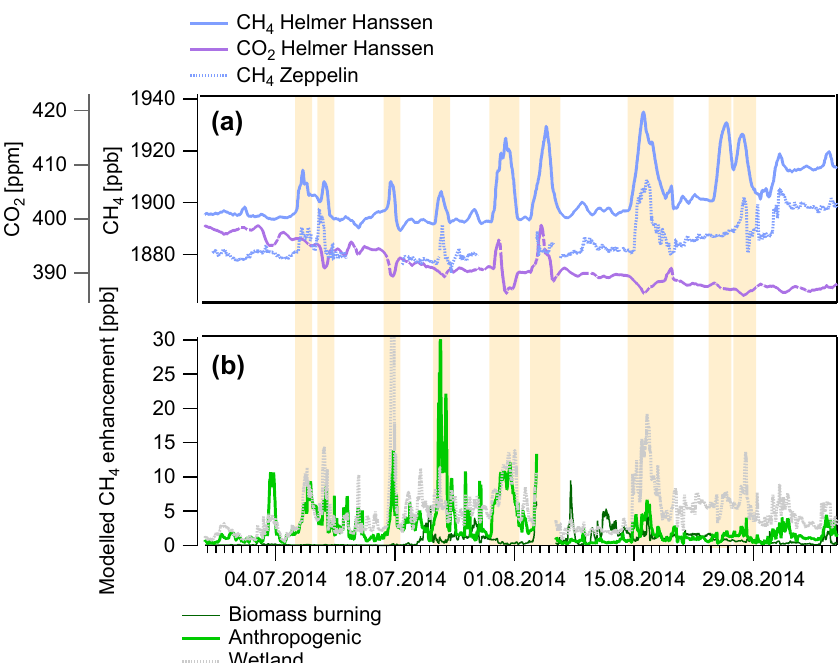
Figure 6. Example time series and model data presented in this study, from summer 2014 data. (a) shows observation data of high time resolution (1h) methane (CH 4 , light blue), carbon dioxide (CO 2 , purple dashed) at the RV Helmer Hanssen , and CH 4 at Zeppelin for ship positions within 75–82 ◦ N, 5–35 ◦ E (blue dotted). (b) shows the modelled CH 4 enhancement due to anthropogenic activity (green), wetlands (grey), and biomass burning (dark green) according to emission inventories and FLEXPART (see text for details). Major excursions in the RV Helmer Hanssen CH 4 mixing ratio are highlighted.